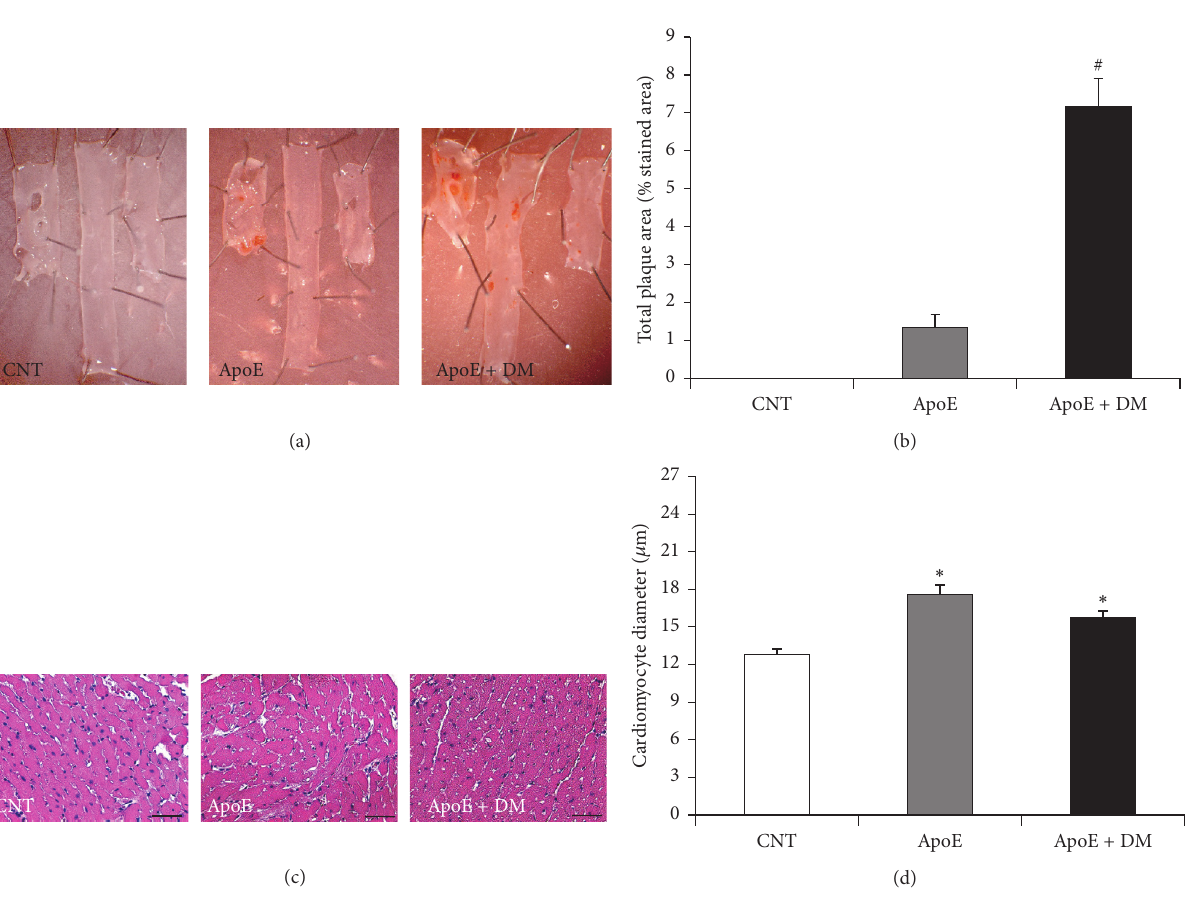
Figure 1: Effect of dyslipidemia and diabetes on atherosclerosis and cardiomyocyte hypertrophy. (a) Representative en face aortic sections showing atherosclerosis. (b) Percentage of the aorta stained red with Sudan IV in each group. Result from CNT is not shown, as there was no plaque present. (c) Representative H&E-stained hearts (original magnification 25x) and (d) related cardiomyocyte size quantification (in 𝜇 m). Scale bar = 50 𝜇 m. Data show mean ± SEM. ∗ 𝑝 < 0.05 versus CNT; # 𝑝 < 0.05 versus ApoE. CNT is for C57BL/6J mice; ApoE is